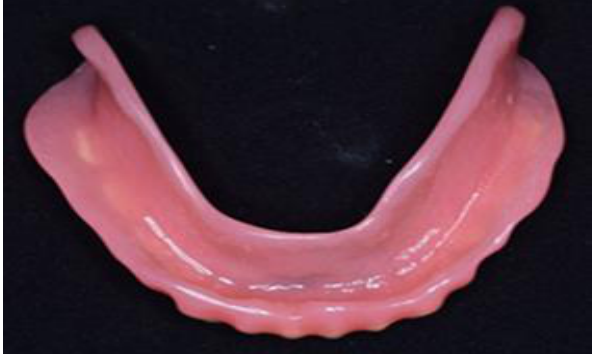
Fig. 5D. Final denture of the lower jaw (intaglio surface).